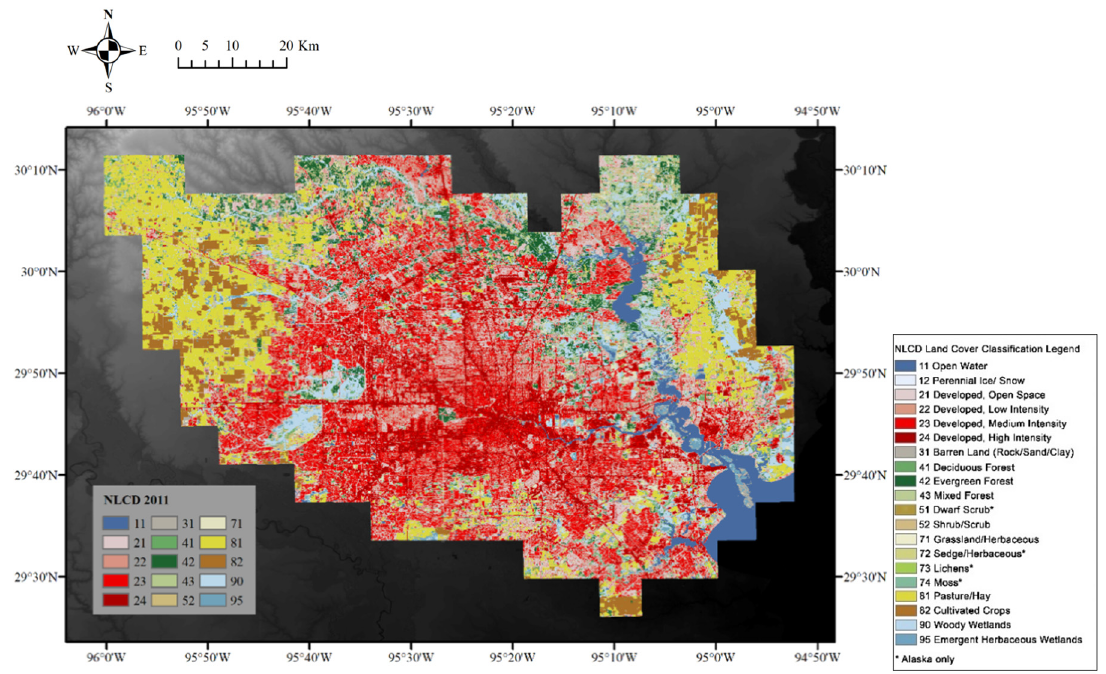
Figure 2. Land use and land cover from NLCD 2011.